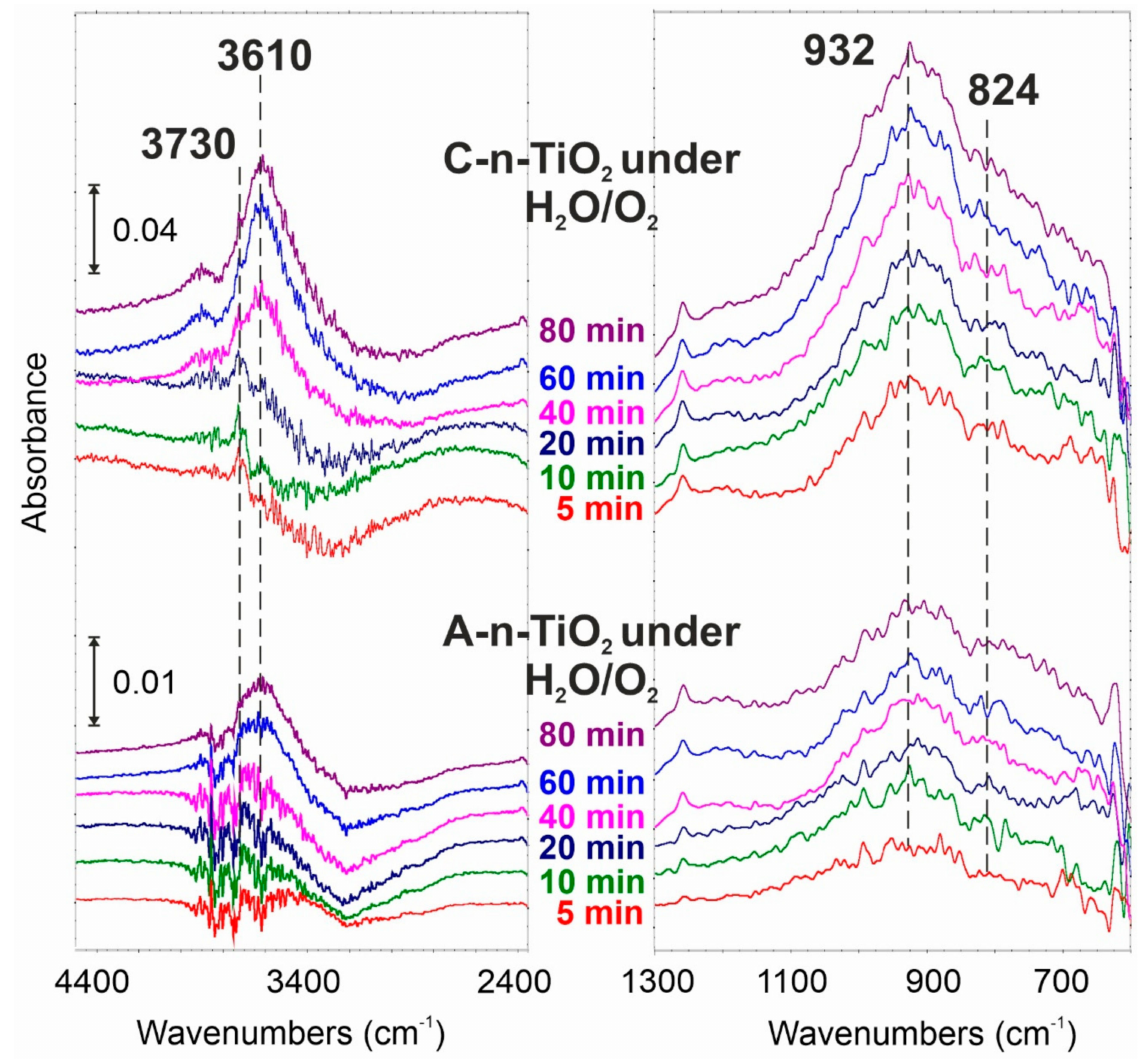
Figure 6. Spectral changes registered after A-n-TiO 2 and C-n-TiO 2 exposition to H 2 O/O 2 atmosphere at 25 ◦